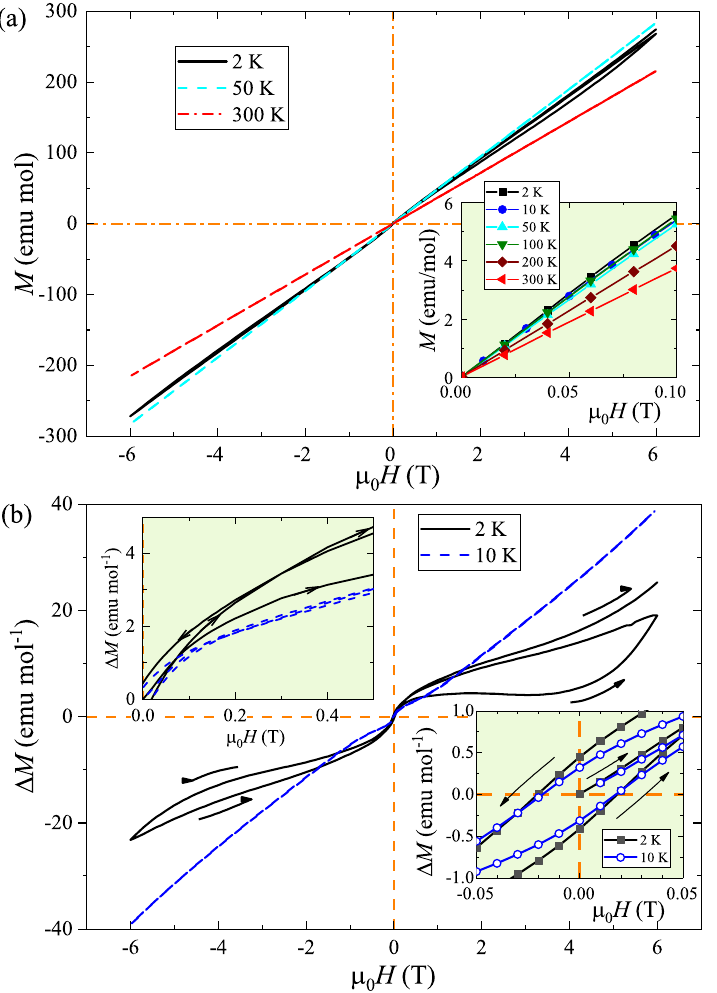
Figure 5. ( a ) Field dependence of magnetization at some selective temperatures for Sr 2 Cr 2 AsO 3 . Panel ( b ) shows the magnetization difference, ∆ M = M − 41.5 H , at 2 and 10 K. All the insets are closeups for showing the details